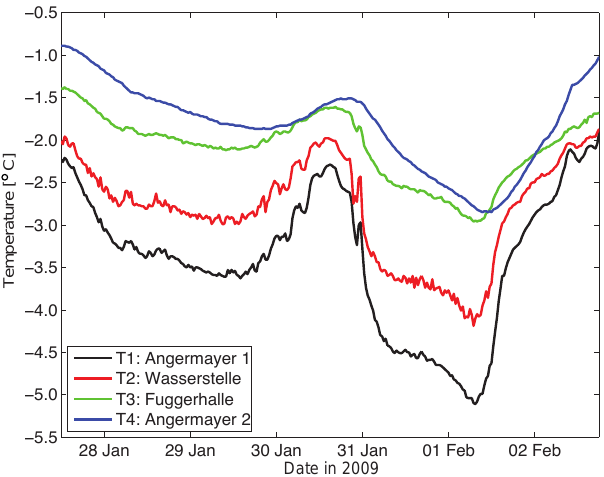
Figure 3. Temperature observations of loggers T1 (Angermayer- halle, lower part), T2 (Wasserstelle), T3 (Fuggerhalle), and T4 (Angermayerhalle, upper part) available for